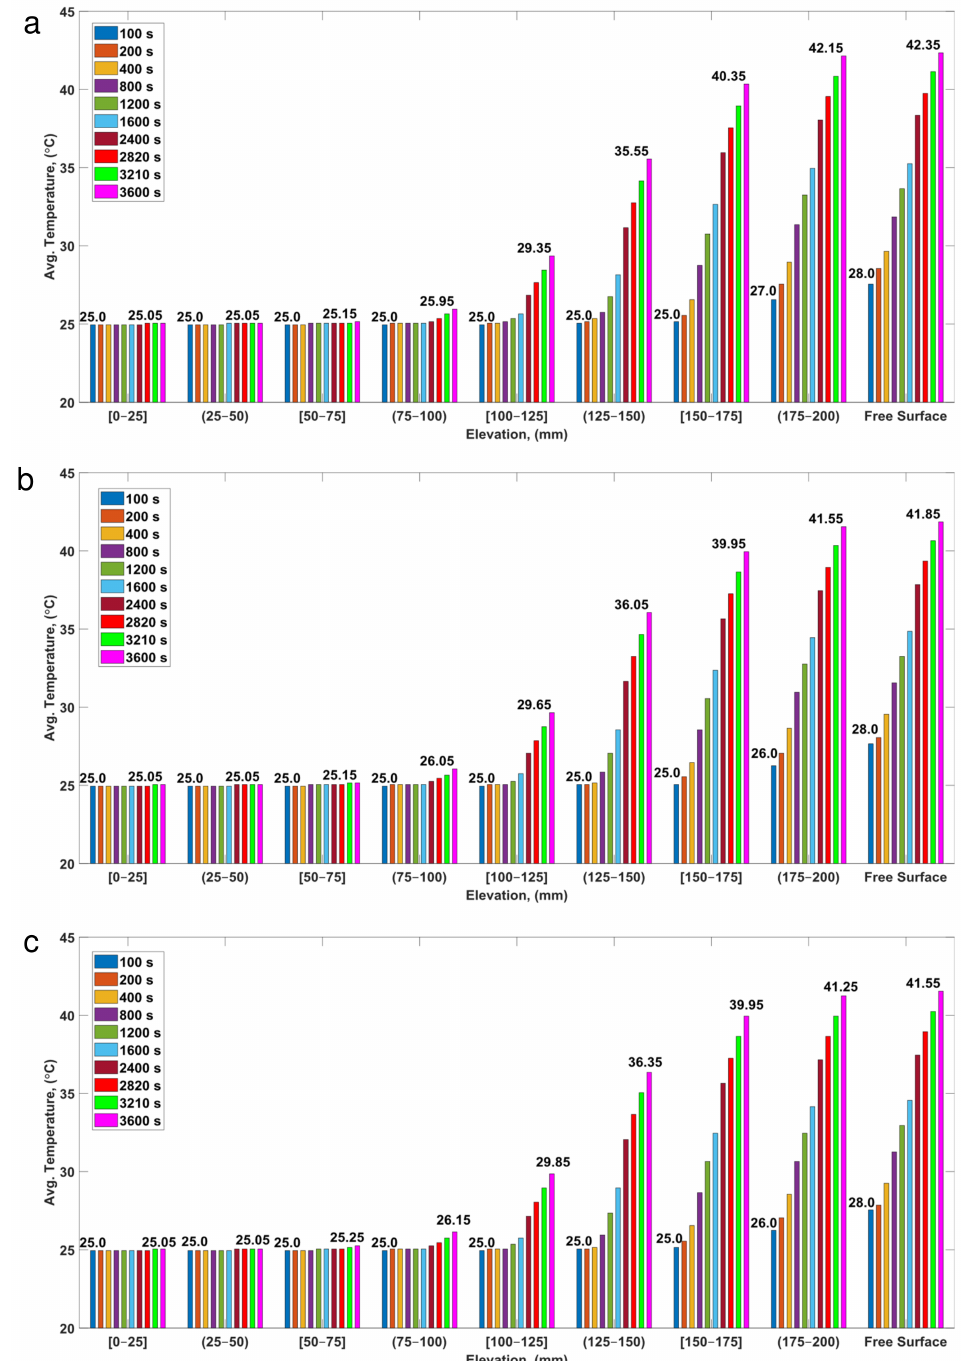
Figure 13. Temporal variation in bulk average temperature with respect to the elevation ranges in the pool for number of heat sources: ( a ) two (Case G), ( b ) three (Case H), and ( c ) four (Case I), which are separated by 180 ◦ , 120 ◦ , and 90 ◦ respectively. Free surface temperature is area-averaged